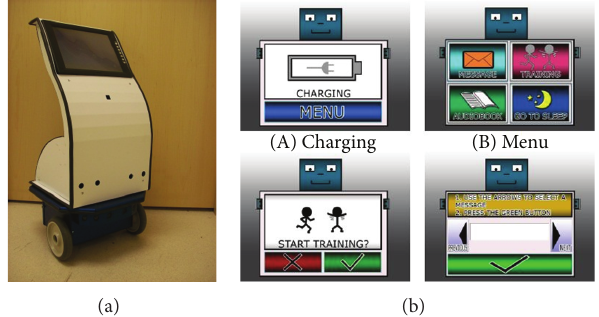
Figure 1: (a) SKOTEE prototype, a computer mounted on an upright mobile device that moves on two wheels. (b) Various screen shots from LCD